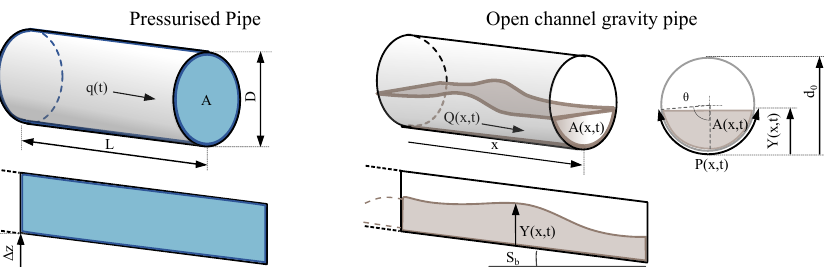
Figure 4. ( Left ) Illustration of a pressurised pipe, ∆ z represents differential the elevation of the pipeline. ( Right ) Illustration of an open channel flow along a longitudinal axis x , S b represents the bed